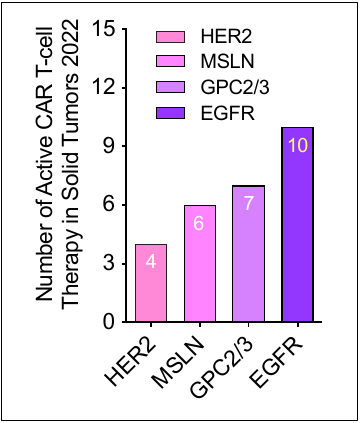
Figure 4. Number of active CAR T-cell trials investigated in 2022. Based on the different antigenic targets, 4 CAR T-cell products are anti-HER2, 6 CAR T-cell products are anti-4 MSLN, 7 CAR T-cell products are anti-4 GPC, 10 CAR T-cell products are anti-EGFR.